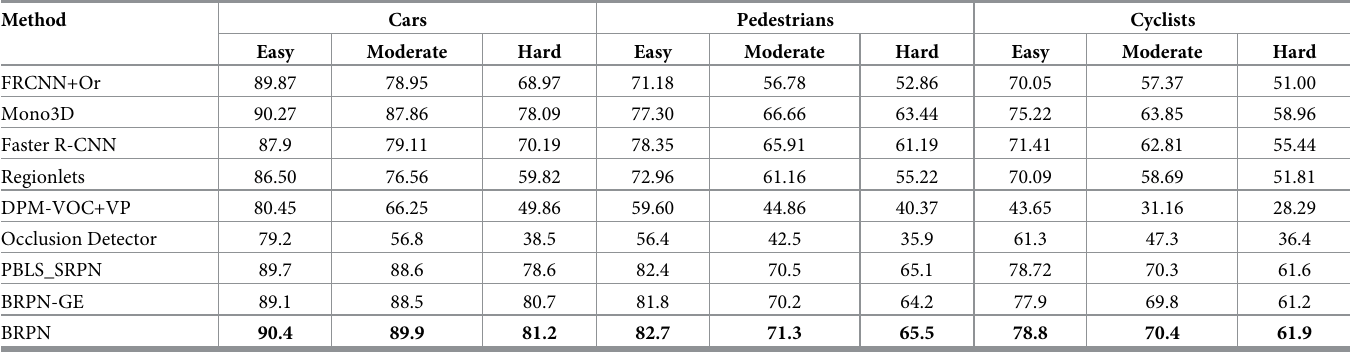
Table 12. Detection results on the KITTI dataset.